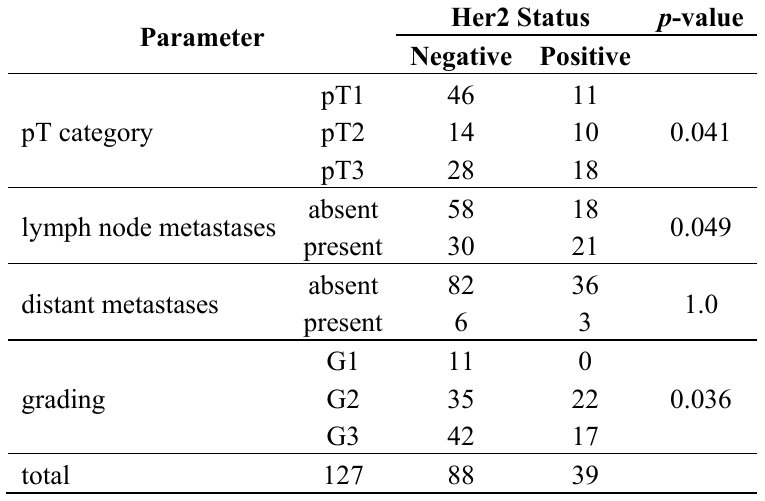
Table 4. Correlation between Her2 status and pathologic characteristics.